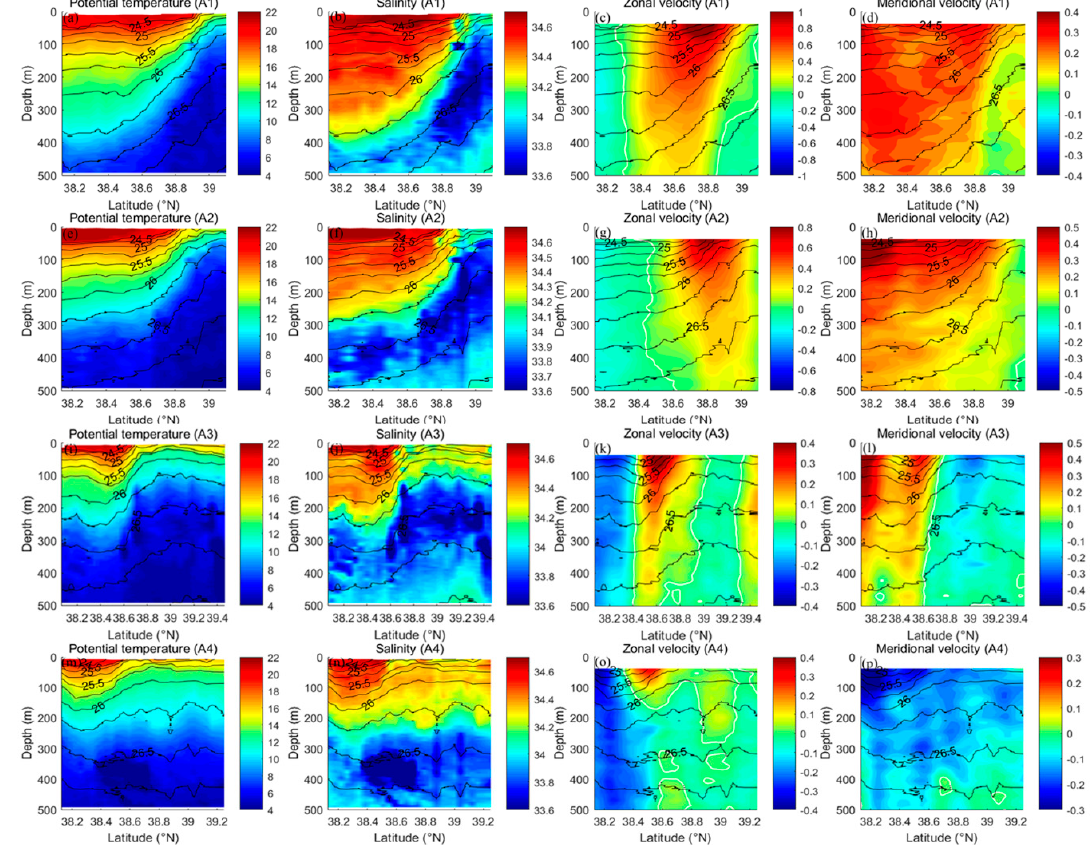
Figure 3. ( a , c , i , m ) Potential temperature (shading in °C), ( b , f , j , n ) salinity (shading in psu), ( c , g , k , o ) Figure 3. ( a , e , i , m ) Potential temperature (shading in ◦ C), ( b , f , j , n ) salinity (shading in psu), ( c , g , k , o ) zonal velocity (shading in m/s) and ( d , h , l , p ) meridional velocity (shading in m/s) of the four sections. zonal velocity (shading in m / s) and ( d , h , l , p ) meridional velocity (shading in m / s) of the four sections. Black contours indicate the potential density (kg/m 3 ) with 0.25 kg/m 3 intervals. White contours Black contours indicate the potential density (kg / m 3 ) with 0.25 kg / m 3 intervals. White contours indicate indicate zero velocity. zero